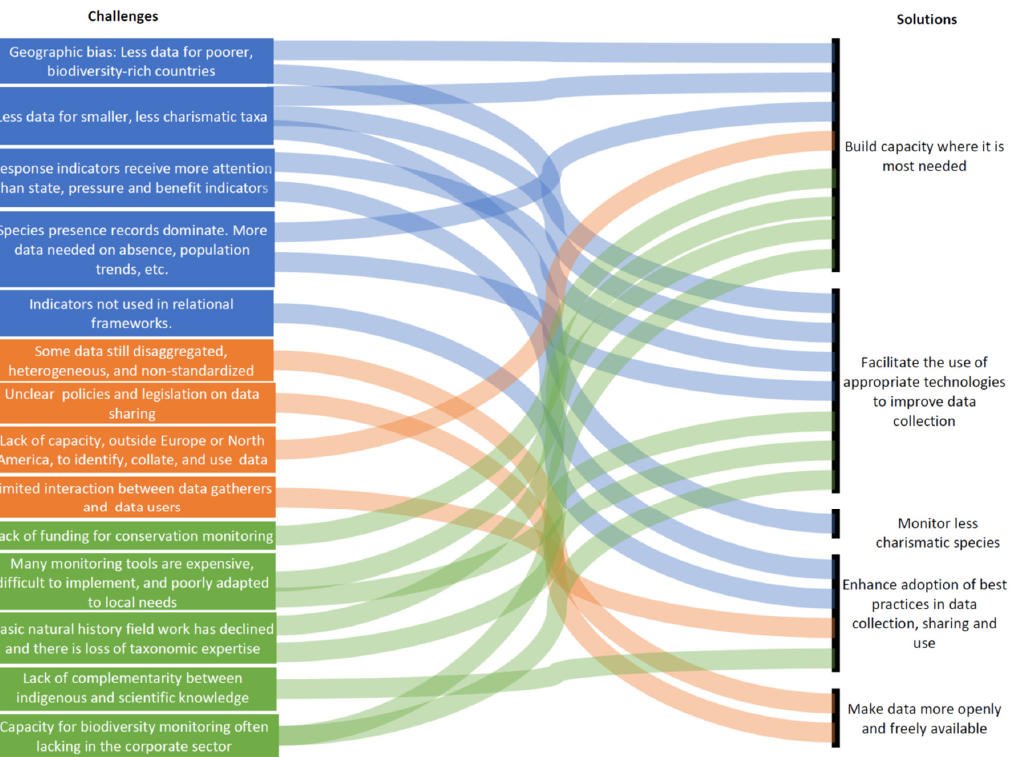
Figure 2. Relationship between challenges to biodiversity monitoring and data use and the solutions to address them. In blue, challenges related to data and research bias; in orange, challenges related to inadequate data availability, sharing, quality and usability; in green, challenges related to technical and financial capacity gaps for data collection, analysis and use, especially in new technologies and key disciplines.